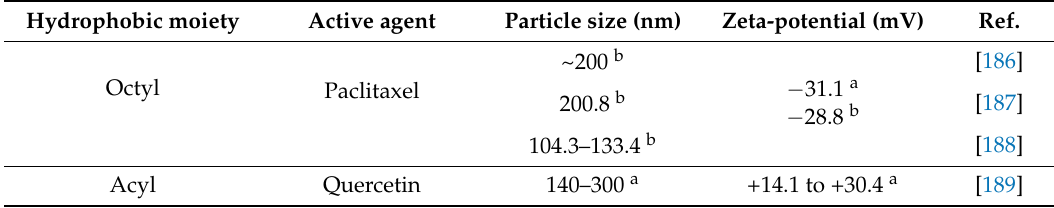
Table 9. Other chitosan